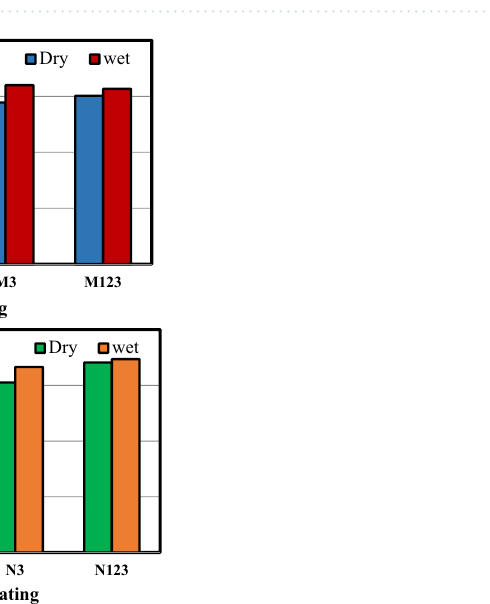
Figure 5. Tensile strength of micro/nanocomposite coating under dry and wet conditions.